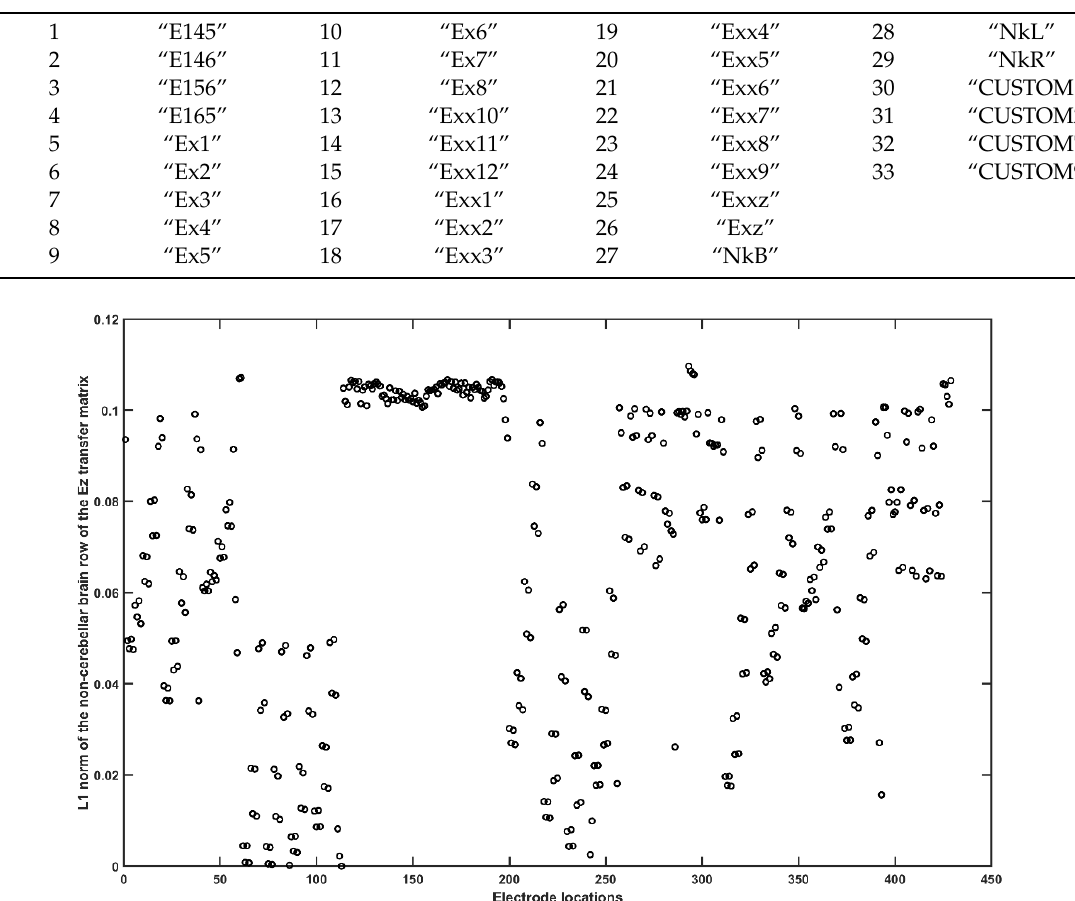
Figure A10 . L1 norm of the non − cerebellar brain row (= 35) of the Ez transfer matrix.